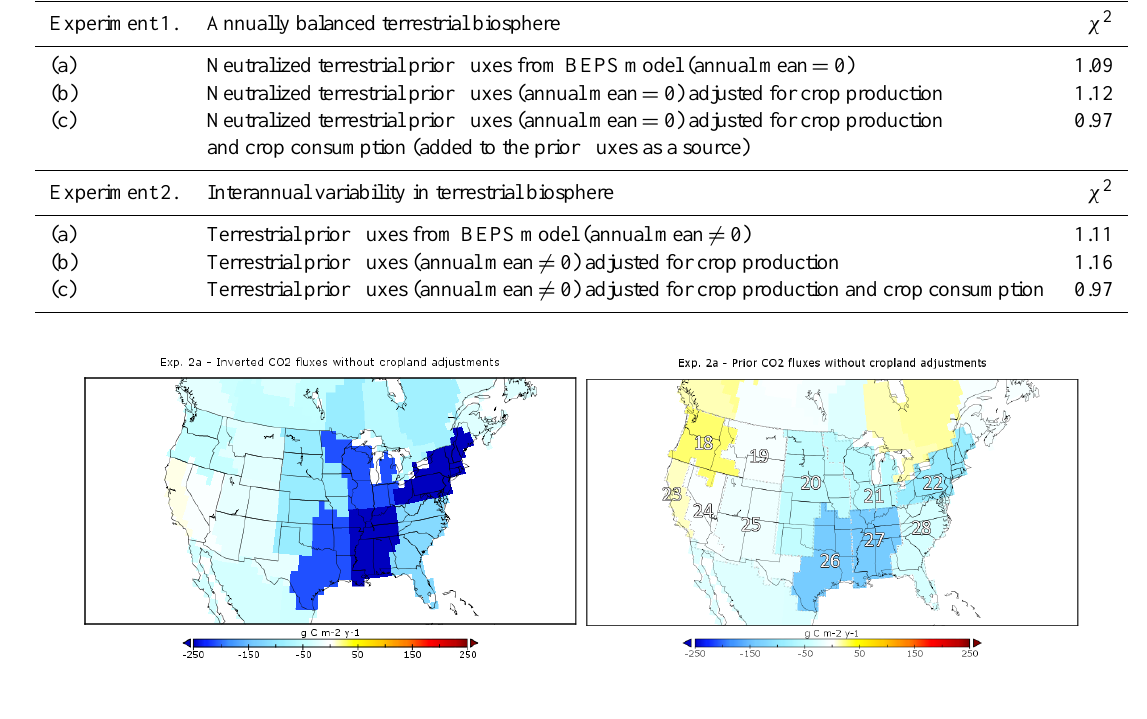
Table 2. Schemes of experiments designed to test for the impact of integrating information from crop production and consumption data into the prior fluxes.